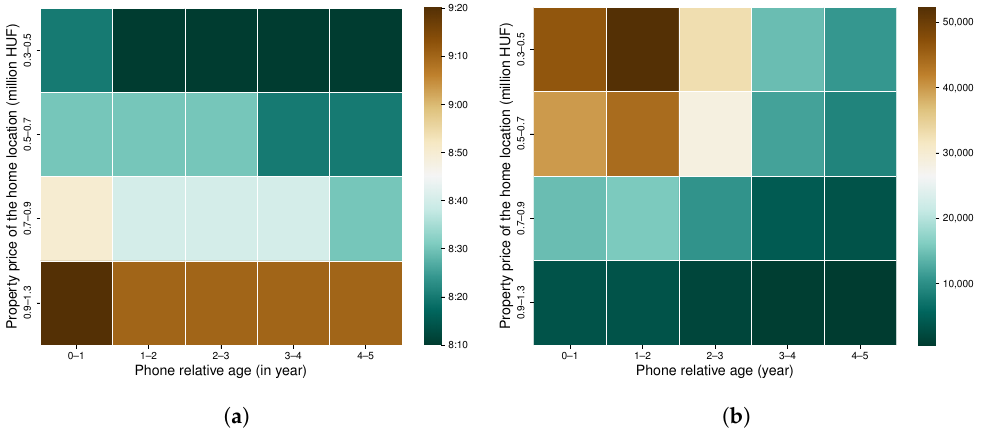
Figure 21. The inhabitant-based wake-up times in the socioeconomic categories, based on the property price of the home location and the relative age of the mobile phone ( a ), and the number of the subscribers in each category ( b